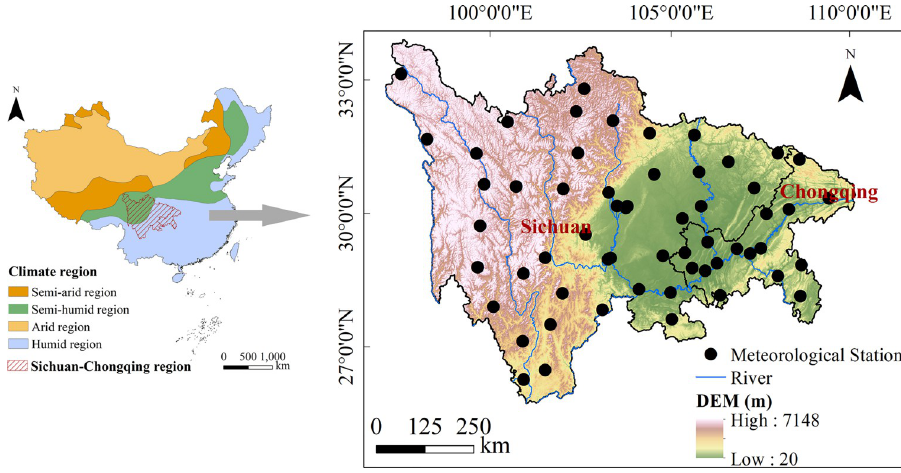
Fig 1. Digital elevation model (DEM) and location of all 56 standard meteorological stations and major rivers in the Sichuan-Chongqing region, China.